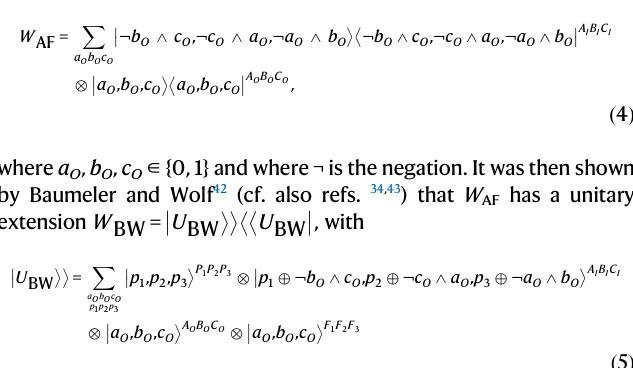
Fig.5|Realisationontime-delocalisedsubsystemsof ∣ UBW particular process, the two circuit operations ω (cid:7) 2 and ω (cid:8) 2 do not depend on U C . For simplicity of the representation, the identity channels 1 1 T 0 2 ! (cid:2) T 0 2 , 1 (cid:2) Q 1 ! Q 1 and 1 Q 0 2 ! (cid:2) Q 0 2 that constitute the blue circuit fragment in Fig. 4